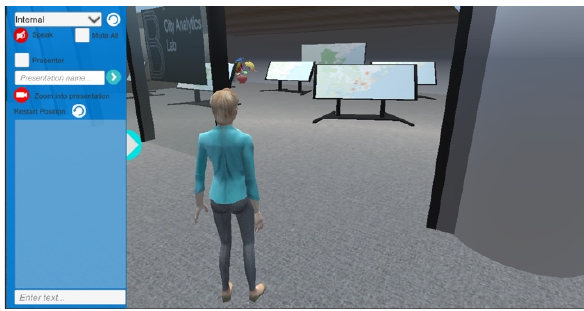
Figure 5: User presence and capabilities of the platform When it comes to the interactive panels, the main idea is to replicate their capabilities. The first and the main aspect that should be dealt with is the image that we want to render on an interactive panel. The interactive panels in the UNSW City Analytics Lab have the option to show a map coming from a website. In our case, since we want to achieve the same in the WebGL we would need to render a webpage within a webpage.